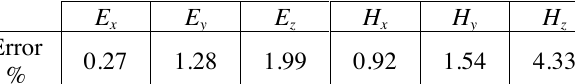
Table 1: Relative errors of E- and H-field maps obtained in the frequency-domain.